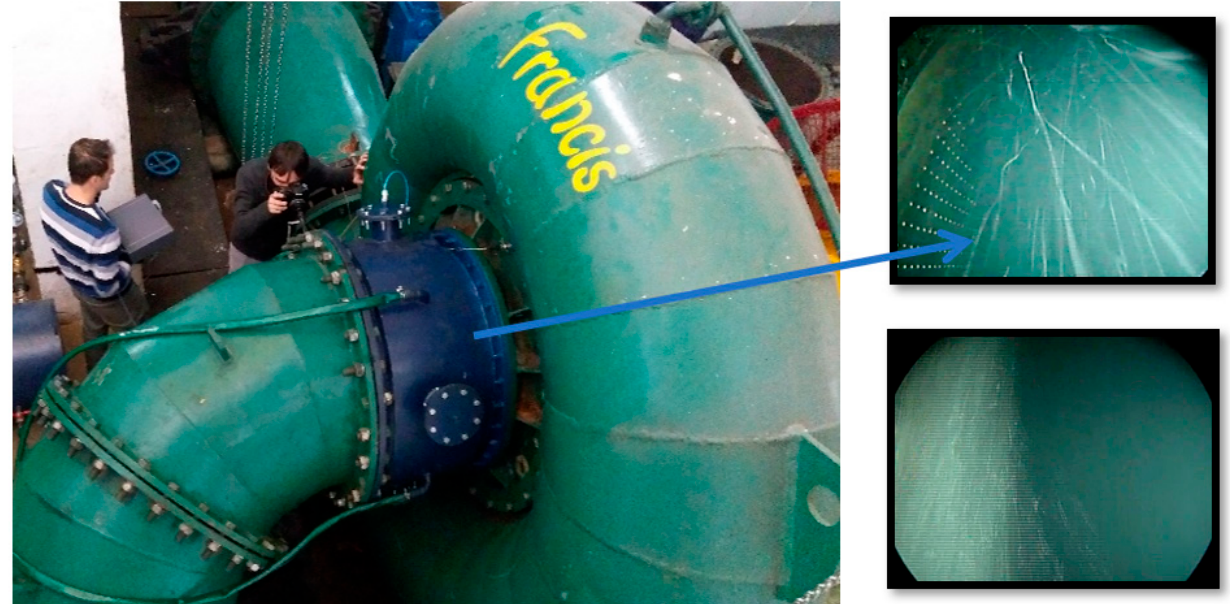
Figure 6. Implementation of the aeration prototype in hydraulic turbines and bubble flow visualization inside the draft tube cone.